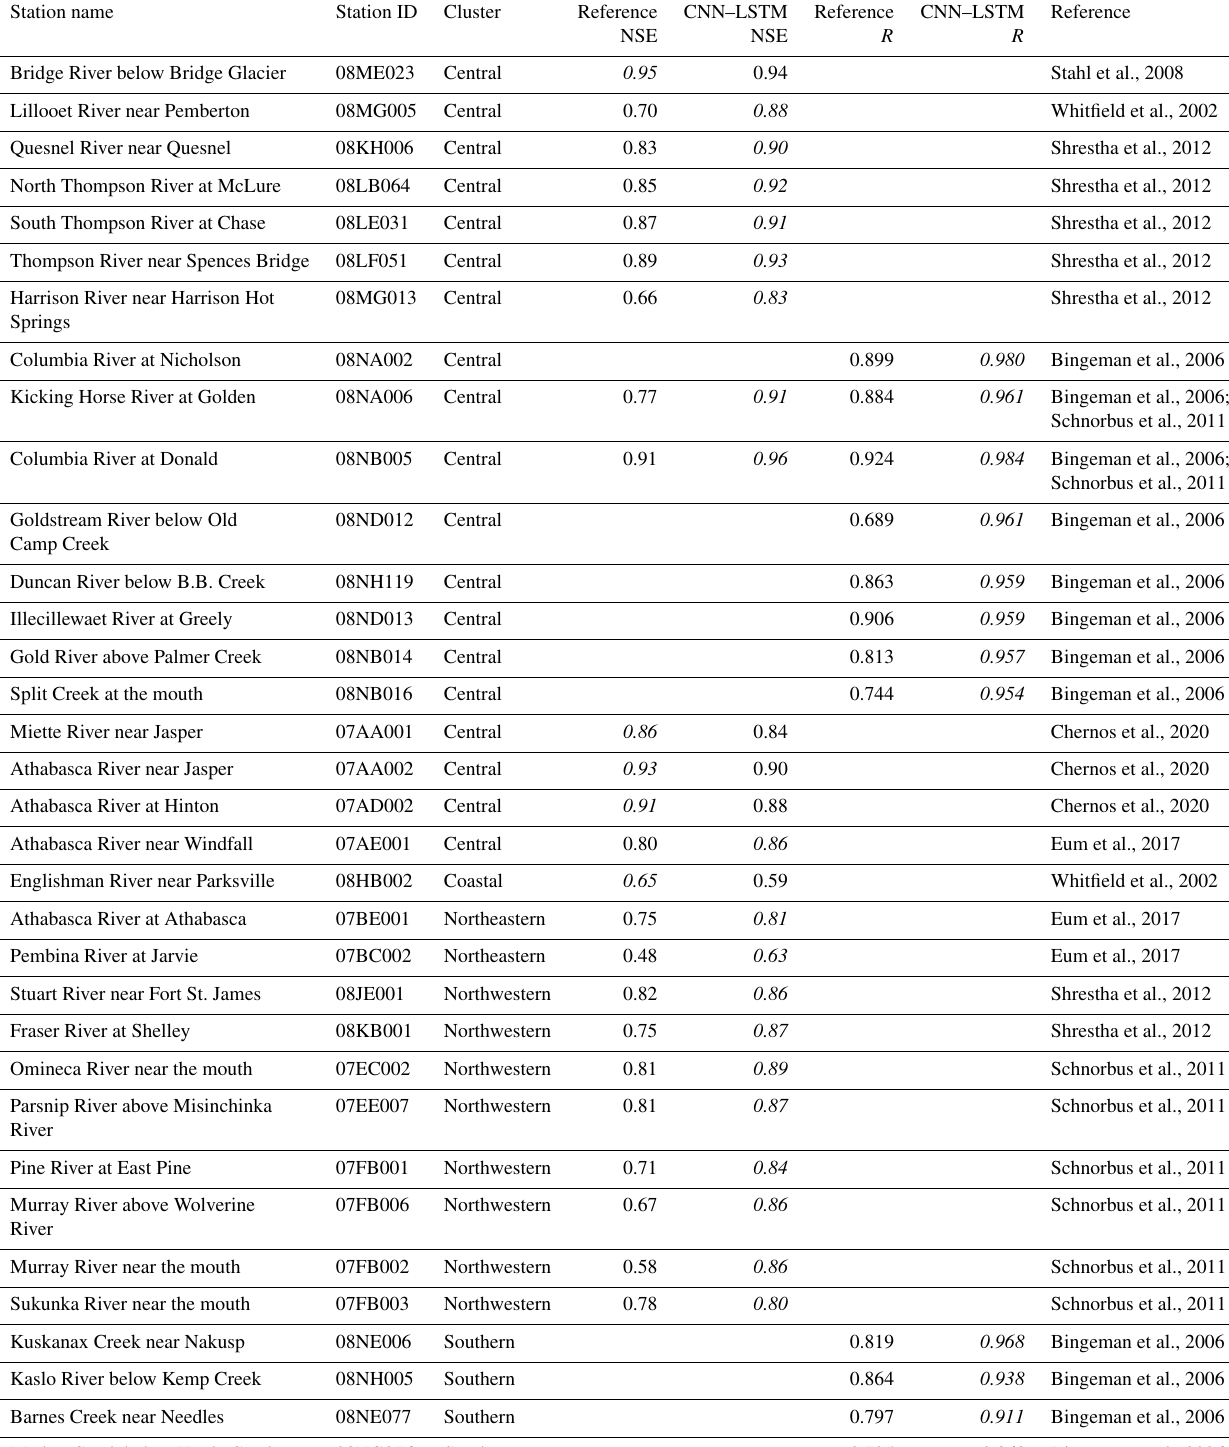
Table 2. Comparison to select process-based models. Metrics for comparison are Nash–Sutcliffe efficiency (NSE) or correlation coefficient ( R ). For our CNN–LSTM model, the performance metrics are calculated from the test set (between 2011–2015). For the reference models, performance metrics are as reported for the validation set (various validation periods). Indicated in italics is the better performing (higher) value between the two